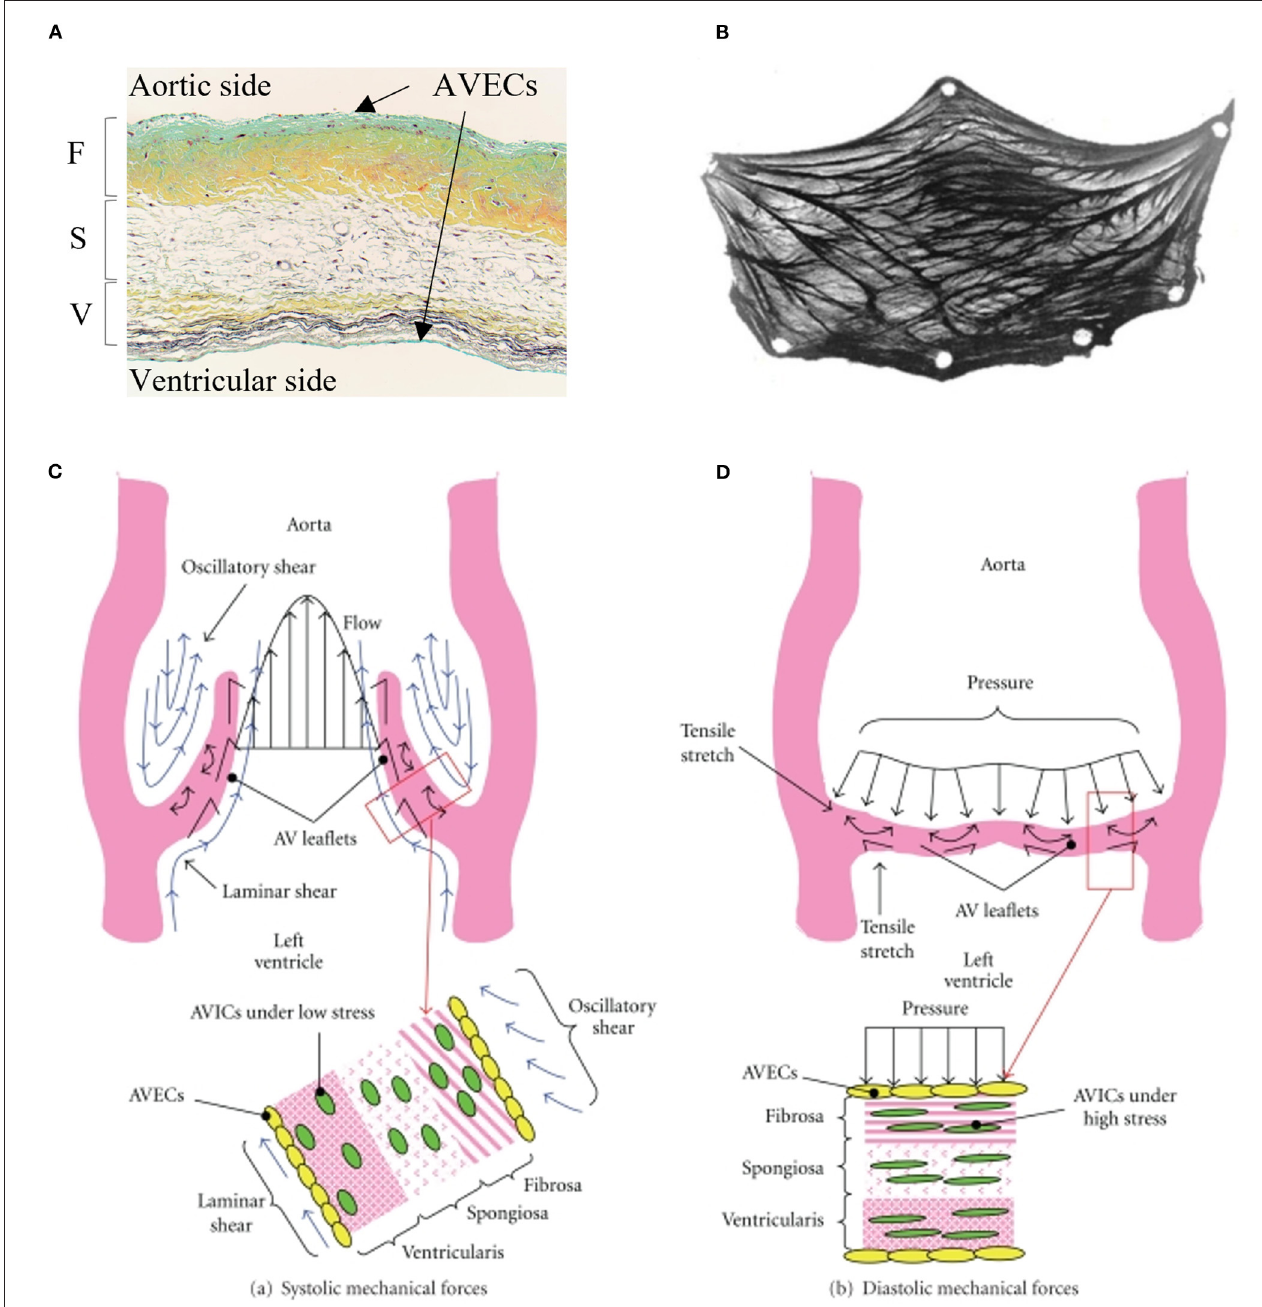
FIGURE 1 | Microscopic and macroscopic overview of aortic valve tissue structure: (A) histological section of the aortic valve leaflet showing three layers: fibrosa (F), spongiosa (S), and ventricularis (V) covered by valvular interstitial cells (VICs) and valvular endothelial cells (VlvECs). (B) excised view of the aortic valve leaflet demonstrating fiber structure. Schematic of stress experienced by aortic valve leaflets and valvular cells during (C) systole, and (D) diastole. (A) is from Fishbein et al. (B) is from Driessen et al. (C,D) are from Balachandran et al. with